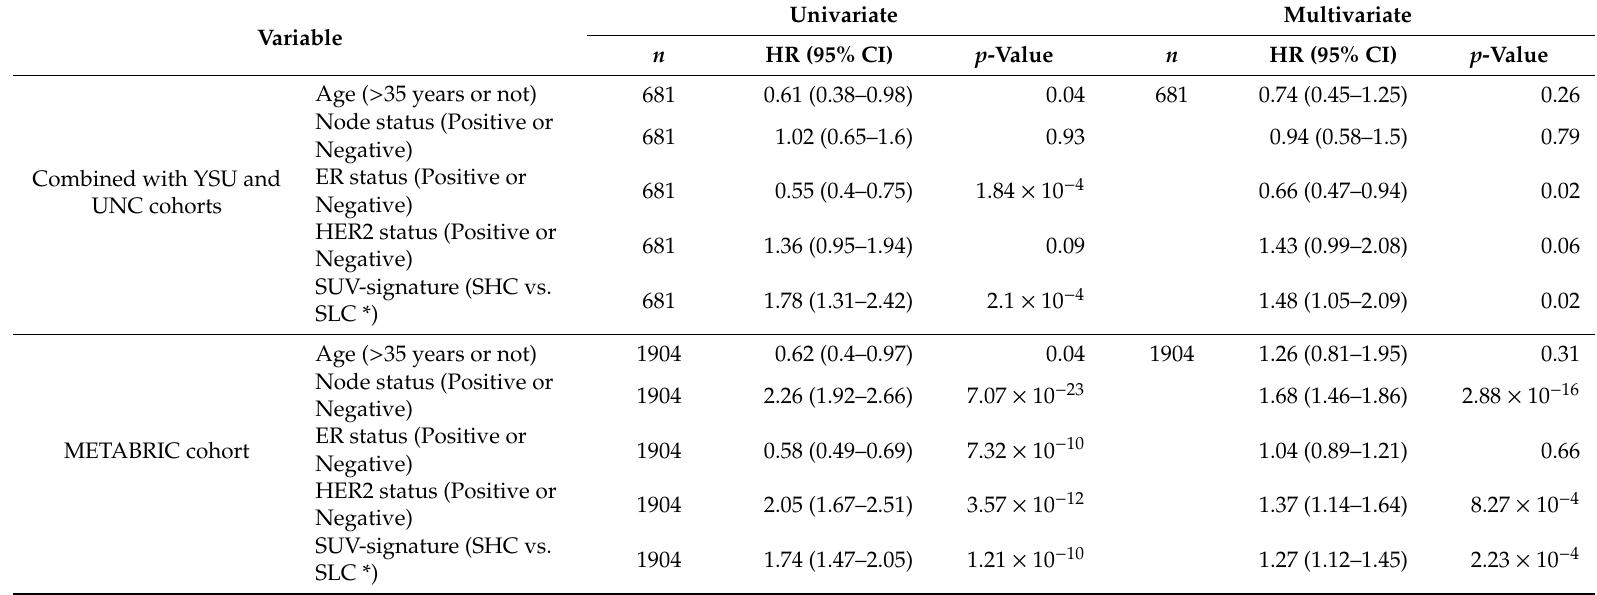
Table 2. Univariate and multivariate Cox regression analysis of disease-free survival in breast cancer. Univariate Variable